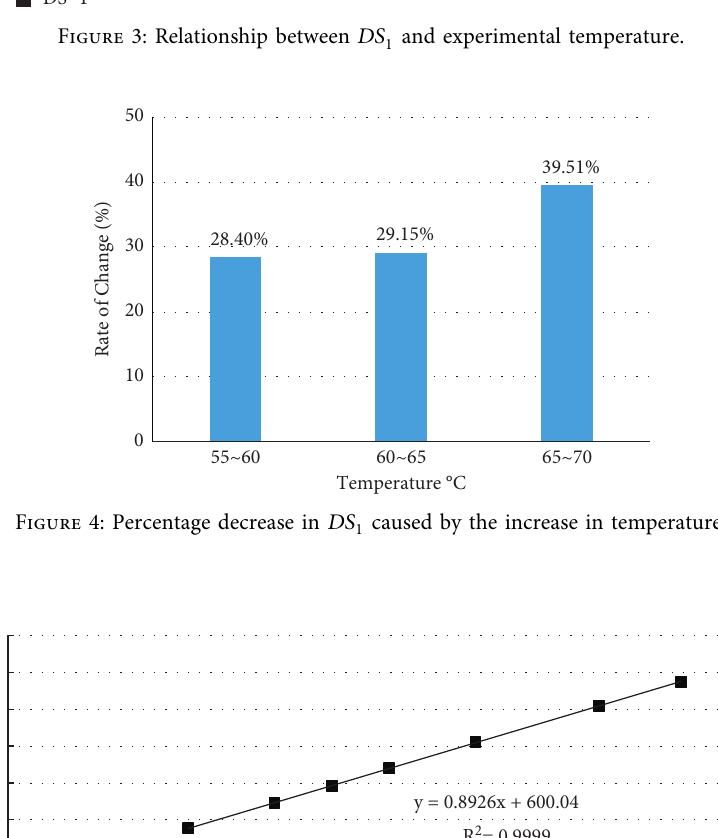
and experimental temperature. 1